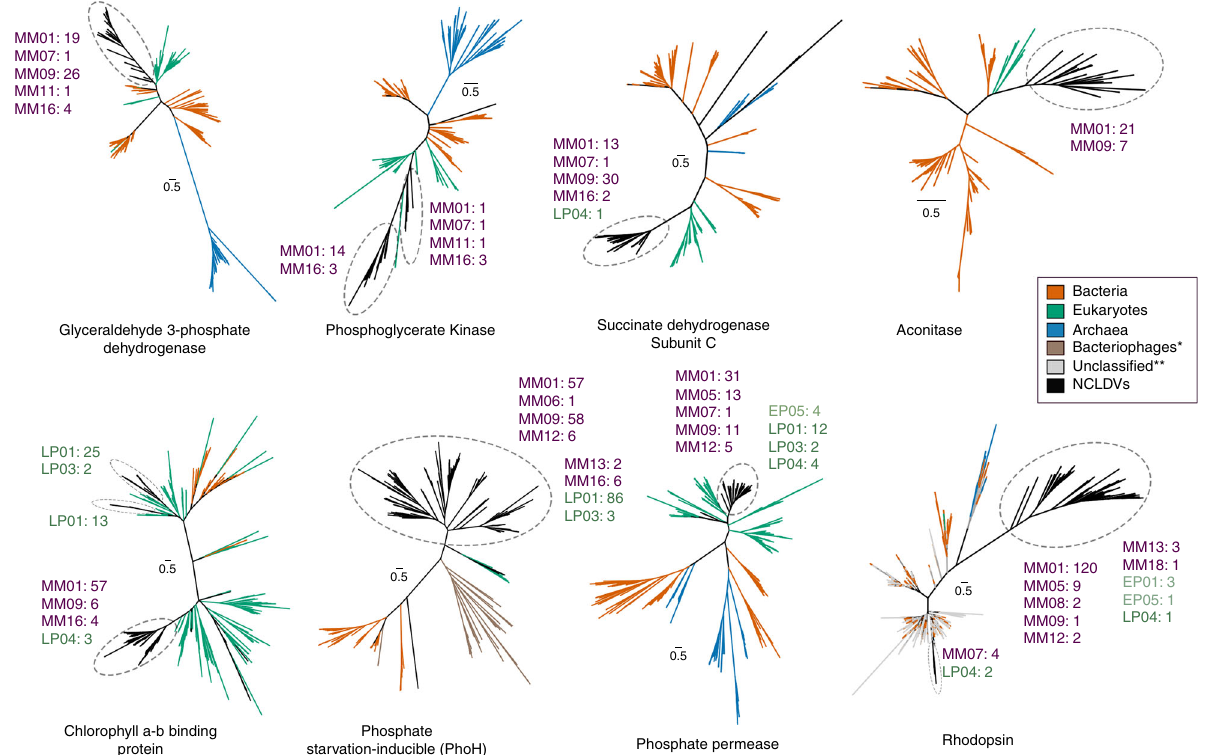
Fig. 5 Phylogenetic reconstruction of a number of representative NCLDV genes likely involved in carbon and nutrient metabolism and light harvesting. NCLDV-speci fi c clusters are encircled with dashed ovals in each of the trees, while number of genes from different NCLDV-clades contributing to these monophyletic groups are also provided (MM: Mimiviridae , EP: Early Phycodnaviridae , LP: Late Phycodnaviridae ) Colors of the clade names correspond to those in Fig. 1. Although node support values are not provided for better visual clarity, all the NCLDV-speci fi c nodes are supported by >90% ultrafast bootstrap values (see Methods and Data availability statement for details). One asterisk denotes bacteriophage sequences, which are only present in the PhoH tree. Double asterisks denote unclassi fi ed sequences (environmental), which are only present in the rhodopsin